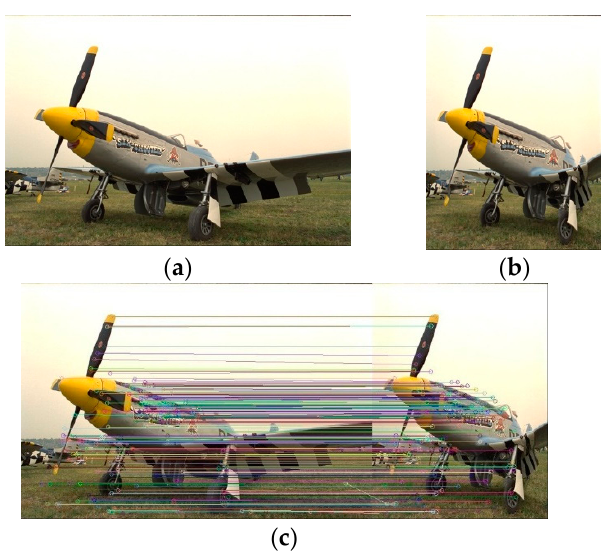
Figure 2. Speed Up Robust Feature (SURF) feature points matching effect picture. ( a ) Original image; ( b ) retargeted image; ( c ) SURF algorithm matching result.